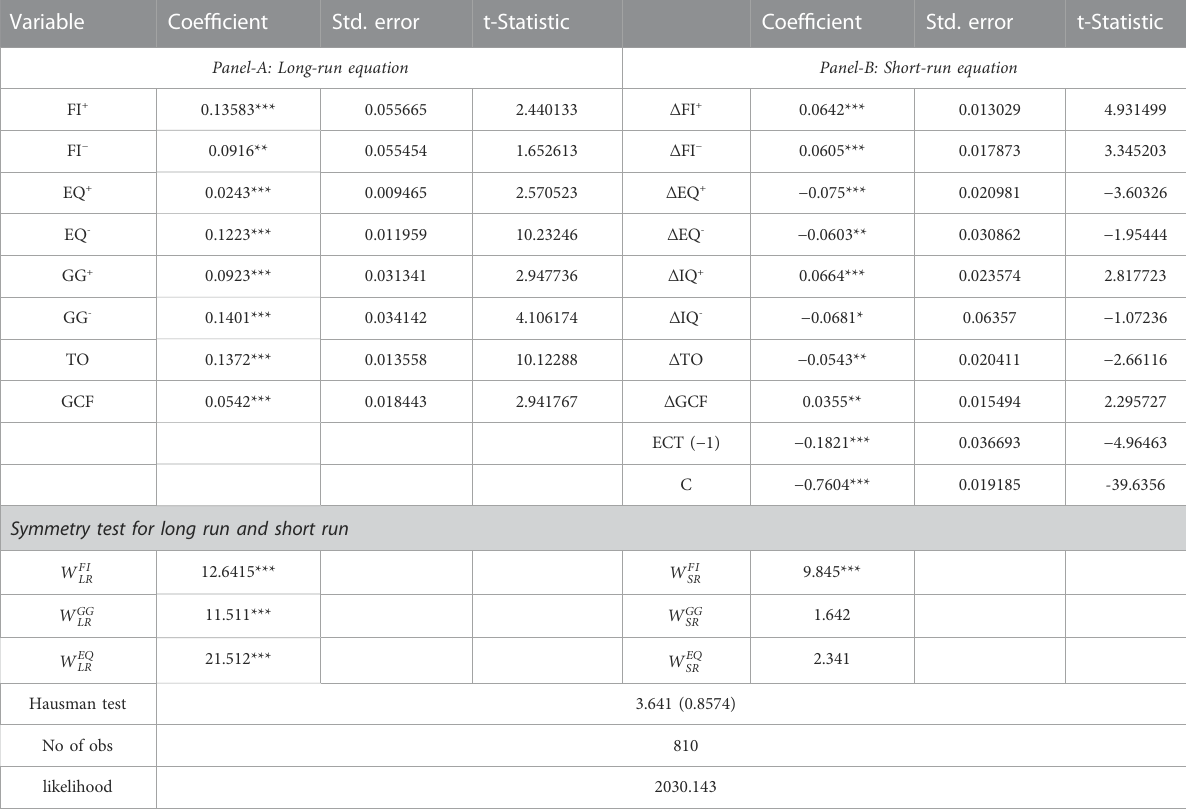
TABLE 8 Results of the asymmetric effect assessment.